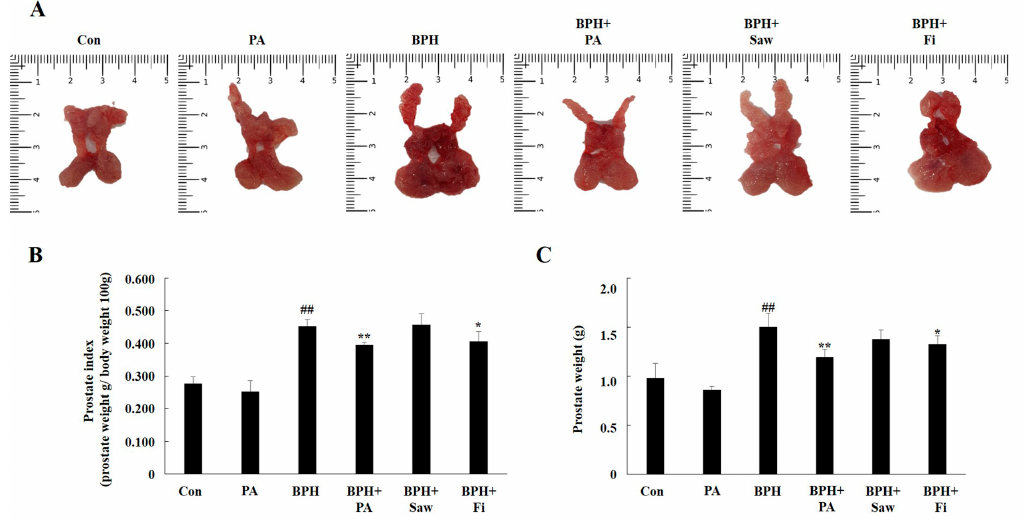
Figure 3. Effect of PA on the prostate weight and prostate index in rats with TP-induced benign prostatic hyperplasia (BPH). Photographs of the prostate tissues (AP, DLP, and VP) ( A ). Total prostate tissue weight ( B ) and prostate indexes of the rats ( C ). Abbreviations: AP, anterior prostate; DLP, dorsolateral prostate; VP, ventral prostate; Con, corn oil, s.c., and D.W.-treated rats; PA, corn oil, s.c. and PA 100 mg/kg-treated rats; BPH, TP, s.c and D.W.-treated castrated rats; BPH + PA, TP, s.c and PA 100 mg/kg-treated castrated rats; BPH + Saw, TP, s.c. and saw palmetto 100 mg/kg-treated castrated rats; BPH + Fi, TP, s.c. and Fi 1 mg/kg-treated castrated rats. The data are expressed as the means ± SEMs. ## p < 0.01, compared with the Con group; * p < 0.05 and ** p < 0.01, compared with the BPH group. d.w.: distilled water, s.c.: subcutaneously.